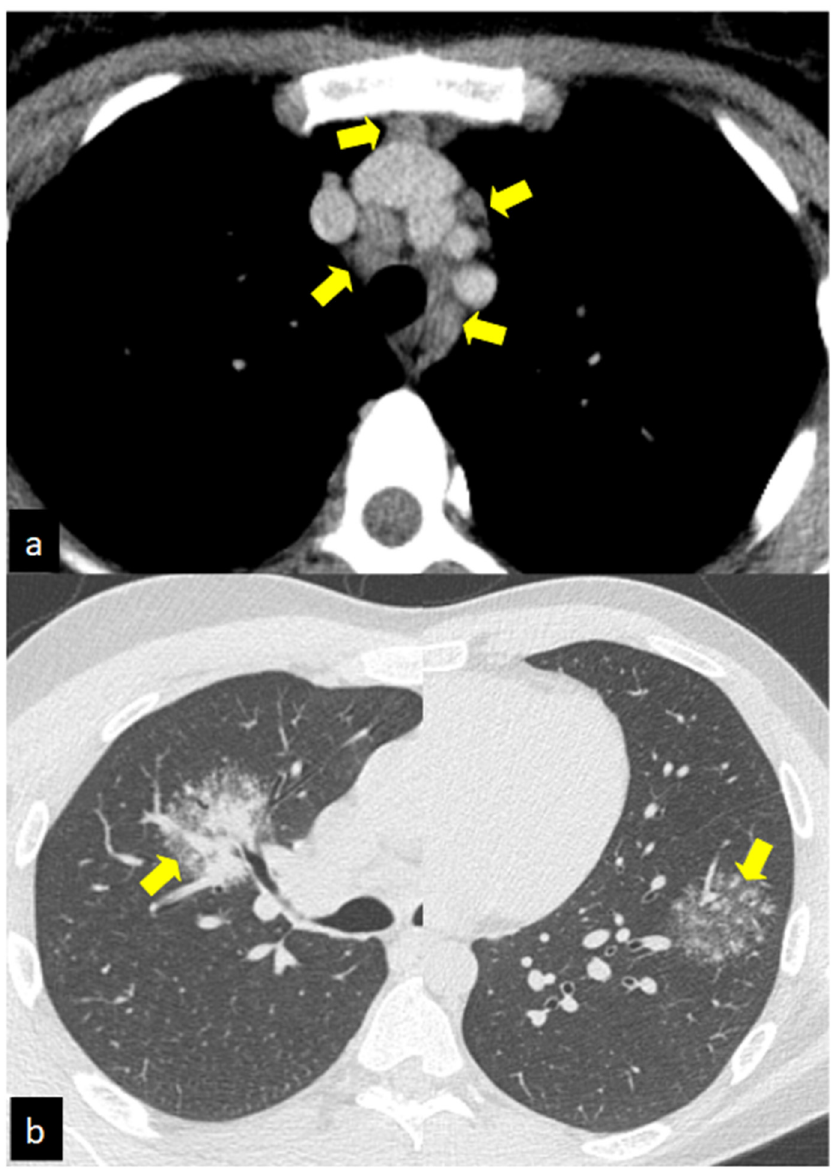
Figure 2. Typical and atypical HRCT manifestations of sarcoidosis. Hilar and mediastinal lymph node enlargement is usually symmetric and bilateral in sarcoidosis (yellow arrows, Figure 2a). Atypical manifestations of sarcoidosis: solitary nodules (1–4 cm diameter), conglomerate masses (“galaxy sign”) (yellow arrows, Figure 2b).